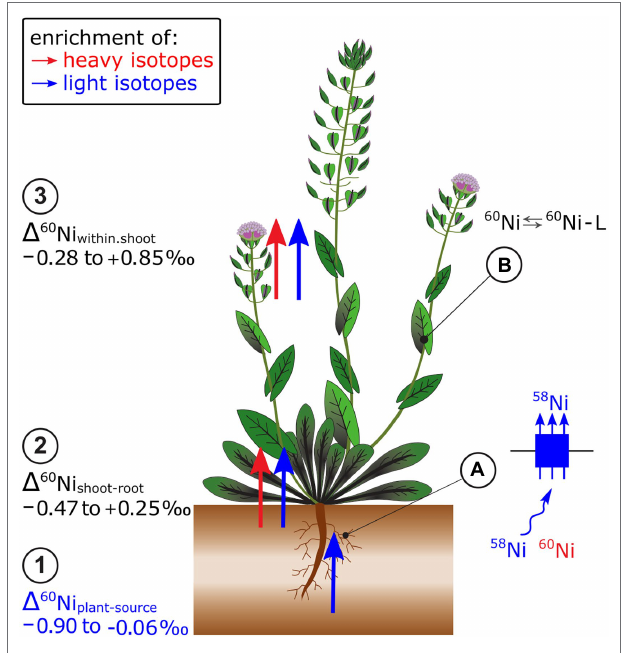
FIGURE 7 | Nickel isotope ratios have been mostly measured in Ni hyperaccumulating plants. (1) Root uptake leads to an enrichment of light Ni isotopes in plants. (2) From roots to shoots as well as (3) within shoots, though no clear pattern of isotope fractionation has been identified so far. (A) It is hypothesized that the enrichment of light isotopes during plant uptake of Ni is induced by low-affinity transport. High Ni uptake rates in hyperaccumulator plants may induce a depletion of Ni in the proximity of the membrane transporters and induce a Ni diffusion which leads to additional enrichment of light isotopes during uptake. (B) Within the shoot, Ni speciation to organic ligands (L), such as citrate, may be excluded as major factor controlling Ni isotope